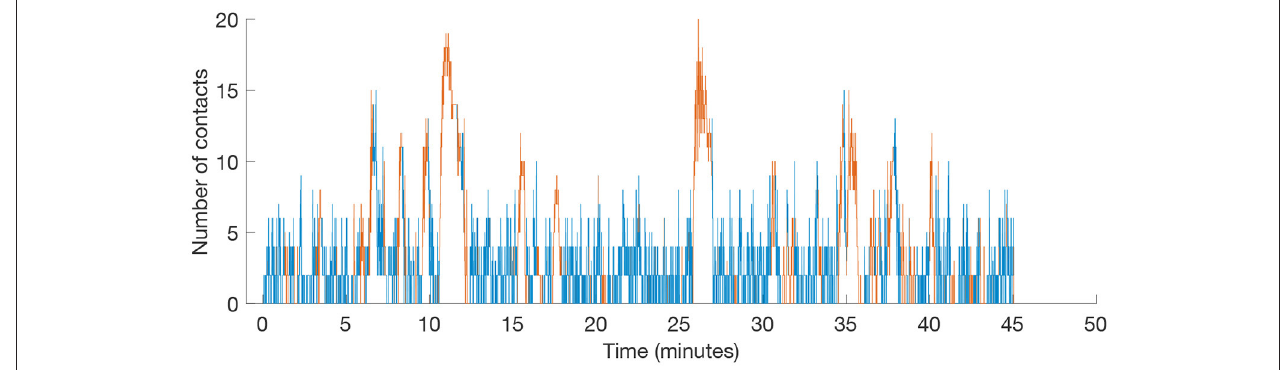
FIGURE 1 | Proximity between players. For a given match played at LaLiga Santander during season 2018/2019, we count how many players are closer than a threshold distance D . In this particular example, D = 2 m. Blue and red colours indicate, respectively, whether the ball is being played or the match is stopped. The highest peaks correspond to fouls (minutes 11 and 26), corners (minutes 6) and the celebration of a goal (minutes 35).